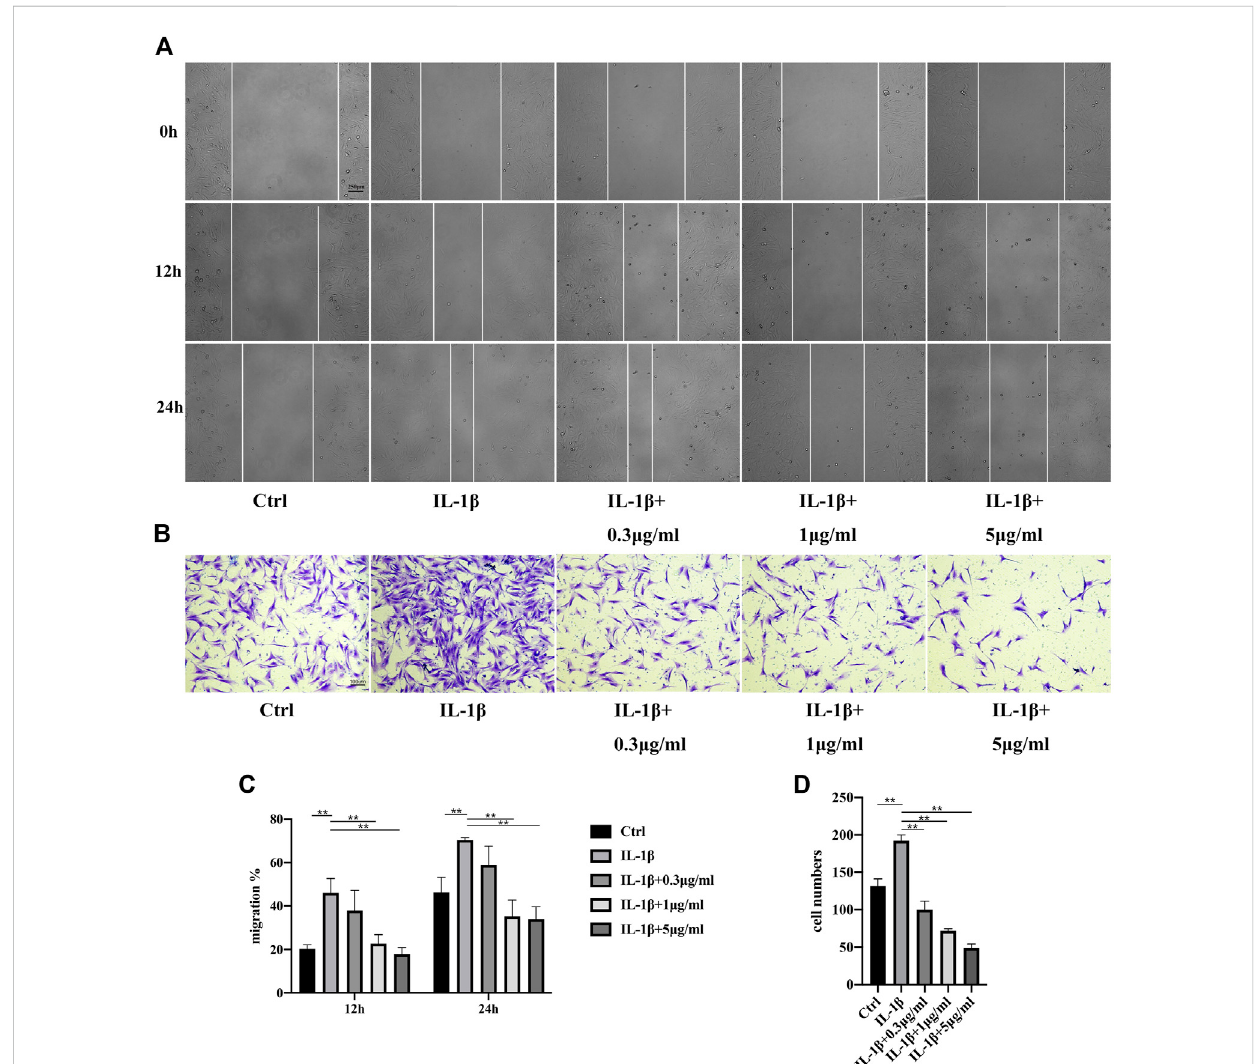
Migration of TCs after IL-1 β (50 ng/mL) and fullerenol treatment. (A) Migration of TCs in control (Ctrl), IL-1 β , IL-1 β +0.3 μ g/mL, IL-1 β +1 μ g/mL, IL- 1 β +5 μ g/mL groups tested by scratch assay. Scale bar = 250 μ m. (B) Migration of TCs in Ctrl, IL-1 β , IL-1 β +0.3 μ g/mL, IL-1 β +1 μ g/mL, IL-1 β +5 μ